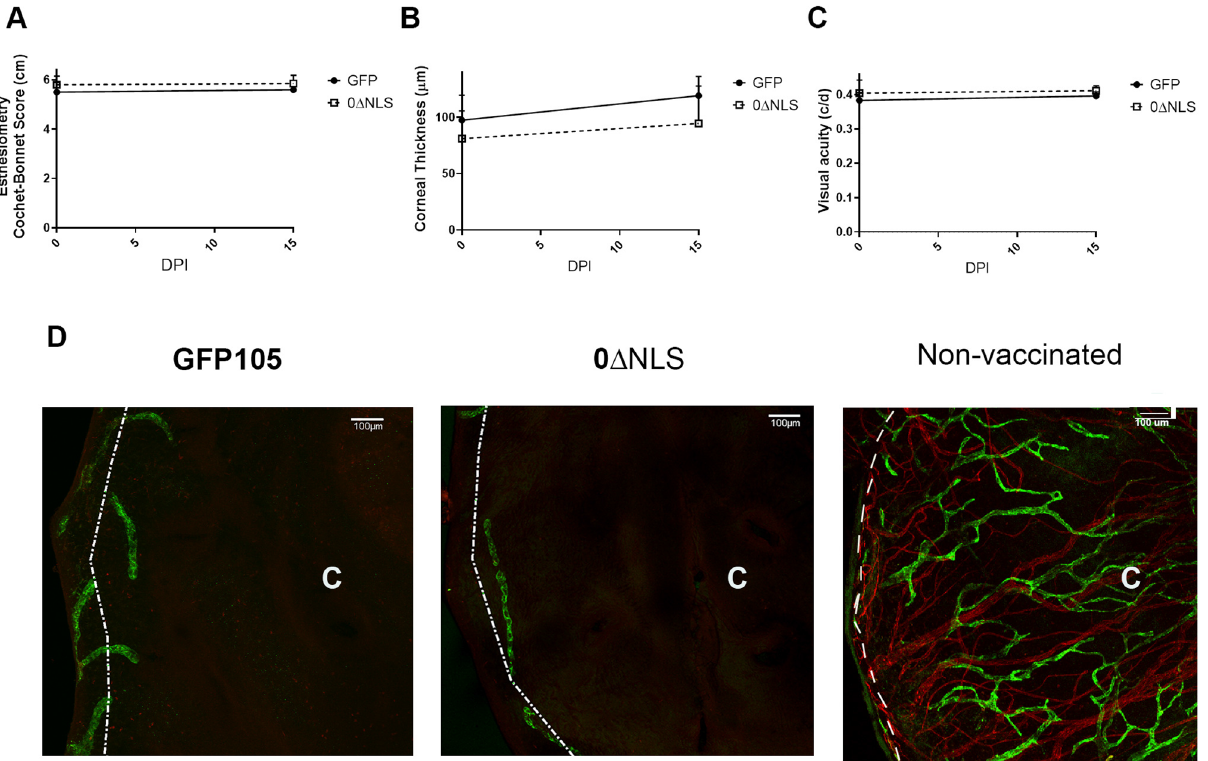
Figure 5. Visual axis is not compromised in vaccinated mice. C57BL/6 mice (n = 10/group) were injected in the footpad with the HSV-1 parental (GFP105) or live-attenuated HSV-1 0ΔNLS at 10 5 plaque forming units (PFU) in 10 µl PBS. At day 21 post immunization, the mice were boosted with the same amount of either parental or live-attenuated HSV-1 virus and left for 30 days. Thirty days after boosting, mice were evaluated for mechanosensory function, edema, and peripheral vision (day 0) prior to challenge with HSV-1 (10 4 PFU/ cornea). At day 15 post infection, the mice were evaluated for ( A ) mechanosensory function measured by an esthesiometer, ( B ) cornea edema measured by optical coherence tomography and ( C ) visual acuity by optokinetic tracking. Mice were then exsanguinated and the corneas removed, processed, and stained for blood (red, CD31 + ) and lymphatic (green, Lyve-1 + ) vessels with images captured by confocal microscopy. A non- vaccinated mouse cornea stained in the same manner shows blood and lymphatic vessel genesis into the central cornea. The “C” indicates the location of the central cornea. The white dotted line depicts the limbus/cornea border. The scale bars are depicted at 100